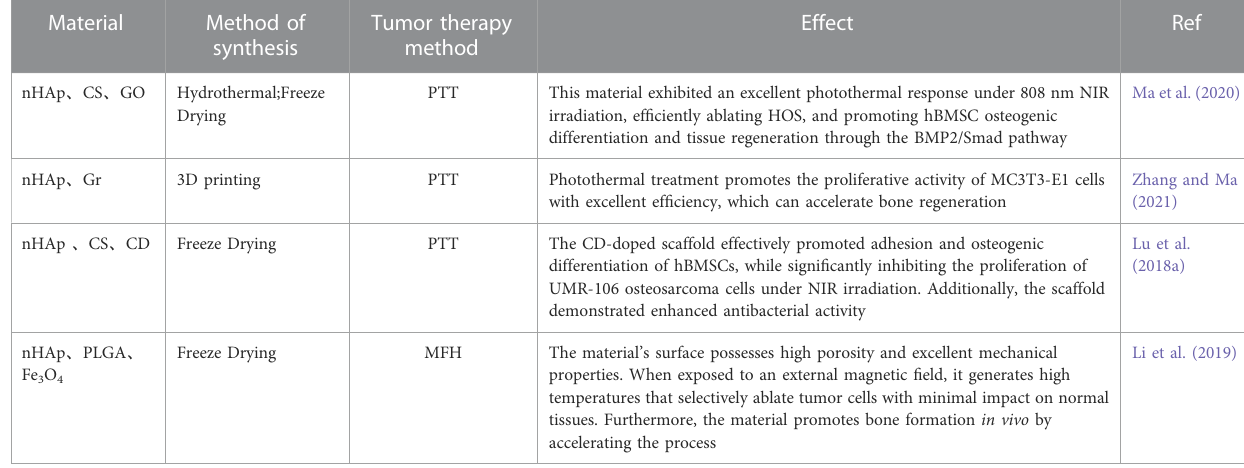
TABLE 2 Composition and synthesis methods of various nHAp composites for PTT and MFH and their effects on tumor tissue.